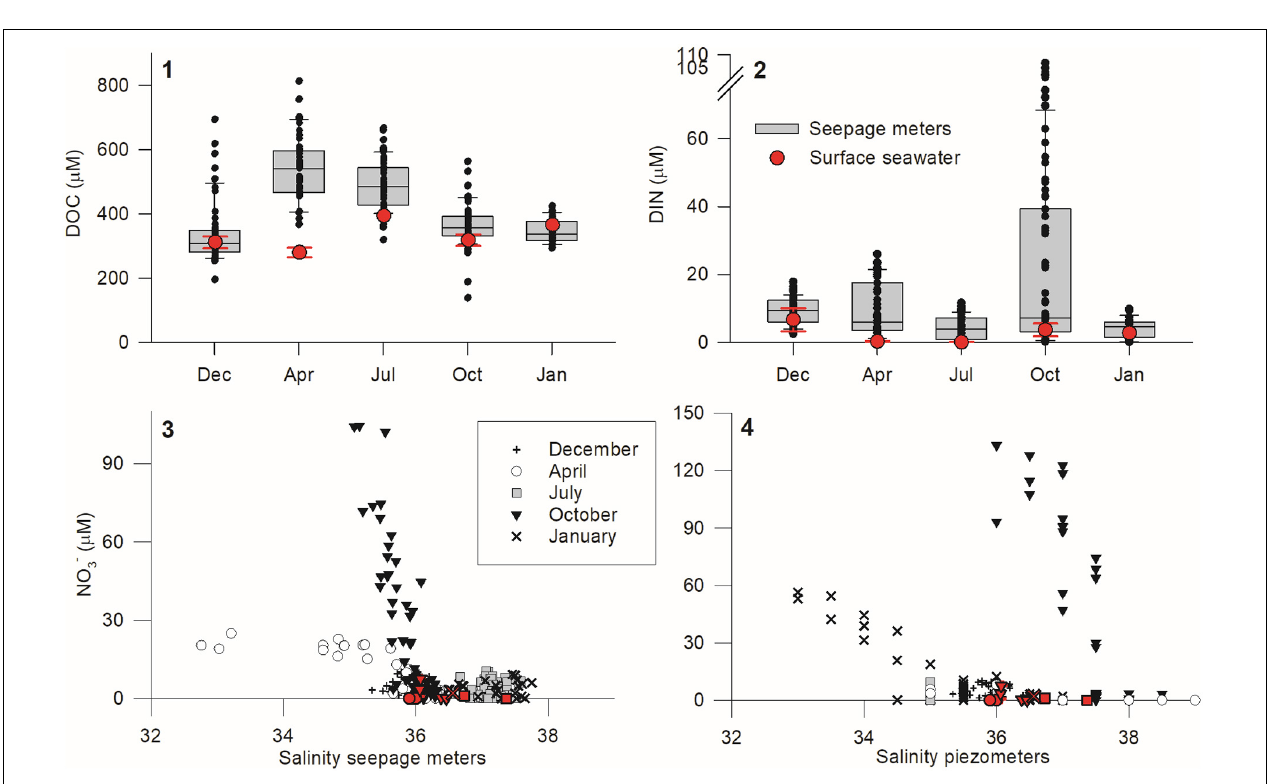
FIGURE 3 | Upper panels : box plot of DOC and DIN concentration range observed in the water samples taken from seepage meters during the five seasonal sampling surveys. Square limits represent the first and the third quartiles, the middle line represents the median, and whiskers are proportional to the interquartile range (IQR) of the data by using 1.58 IQR/(n) 1 / 2 . Average DOC and DIN concentrations measured in the surface seawater at low tide are shown in red as reference. Lower panels : Seasonal